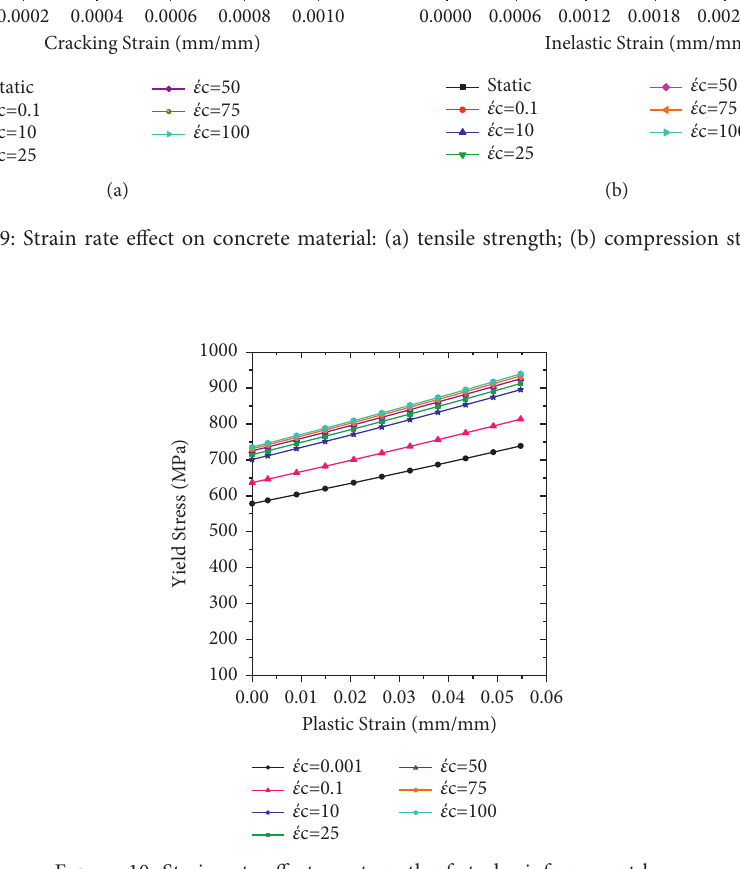
Figure 10: Strain rate effect on strength of steel reinforcement